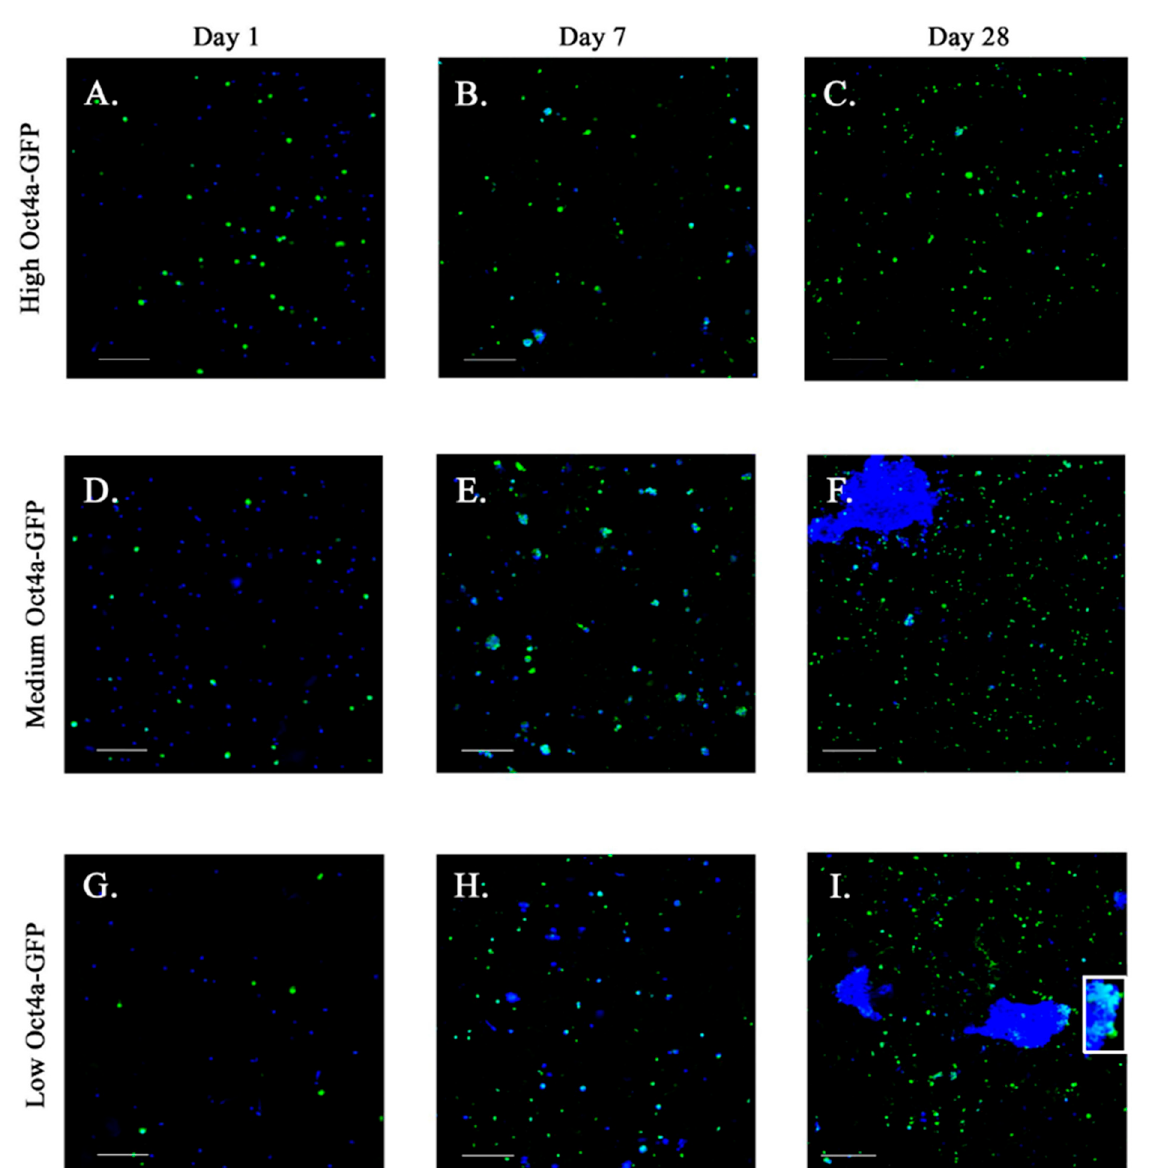
Figure 5. Behavior of bioprinted BC cell subsets in 4:2 scaffolds. MDA-MB-231 breast cancer cells (BCCs) were sorted ( A – C ) as Oct4a GFP-high (cancer stem cell, CSC), ( D – F ) GFP-medium, and ( G – I ) GFP-low cells. The three BCC subsets were printed into 4:2 scaffolds. Confocal images of fixed scaffolds were acquired at days 1 ( A , D , G ), 7 ( B , E , H ), and 28 ( C , F , I ). Representative images at 10 × magnification are shown (n = 3 with 4 technical replicates). Blue: DAPI (nuclei). Green: GFP (Oct4a). Scale bar: 250 µ